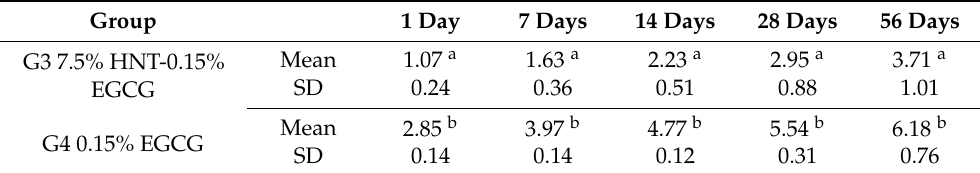
Table 2. EGCG accumulative release ( µ g) detected by UV-vis from EGCG-containing adhesive specimen